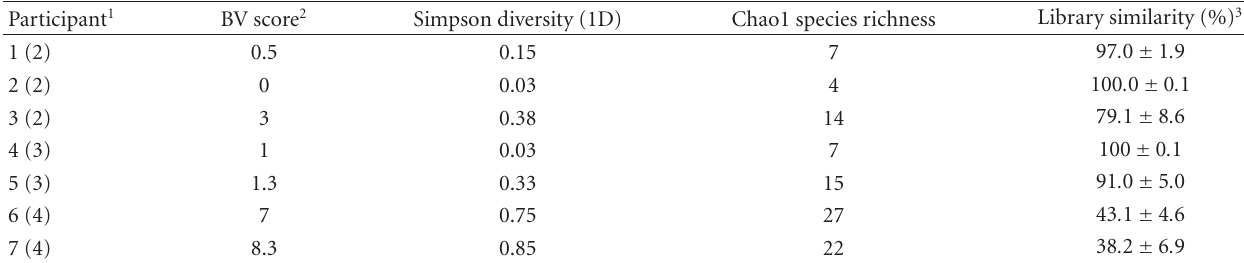
Table 2: Relationship between BV score and the diversity, richness, and stability of the vaginal microbial community.